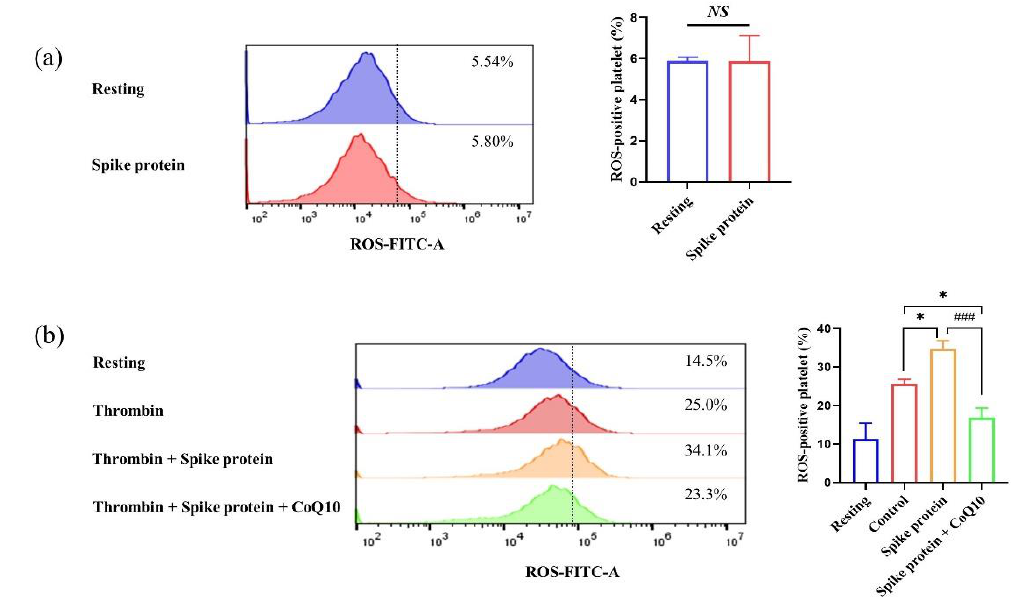
Figure 4. CoQ10 inhibits spike protein-potentiated platelet intracellular ROS. ( a ) DCFH-DA in- cubated platelets were incubated with 2 µ g/mL spike protein for 10 min ( n = 3). ( b ) DCFH-DA incubated platelets were incubated with 100 µ M CoQ10 or solvent for 50 min in the dark, then incubated with 2 μg /mL spike protein for 10 min, followed by stimulation with 1 U/mL thrombin for 30 min. ROS-positive platelet was measured by flow cytometry ( n = 4). All data are presented as mean ± SEM. * p < 0.05 indicate a significant difference compared to the control group. ### p < 0.001 indicates a significant difference between two groups. NS , no significant difference between two groups.